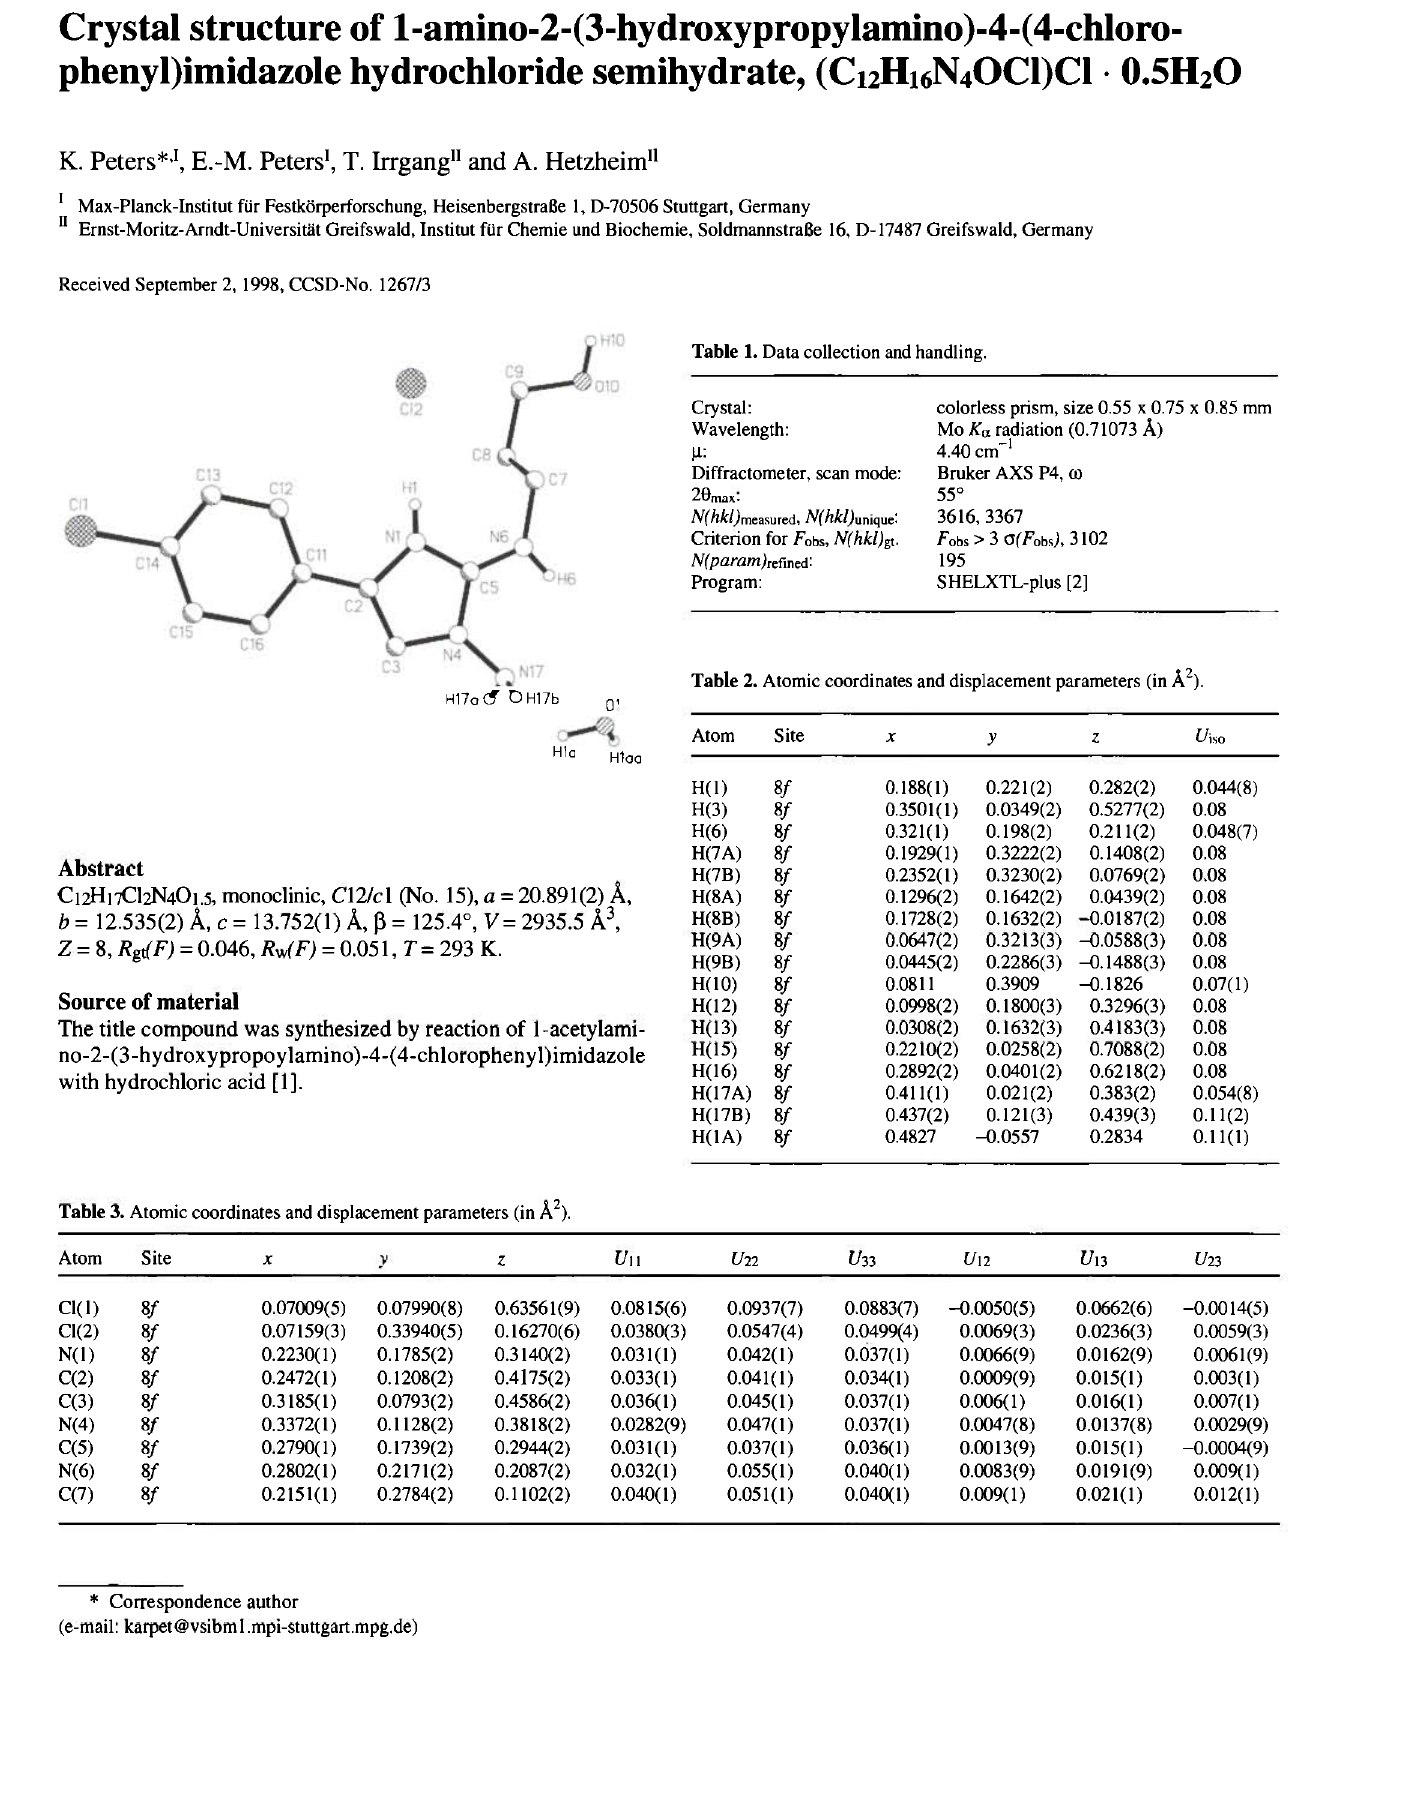
Table 3. Atomic coordinates and displacement parameters (in A 2